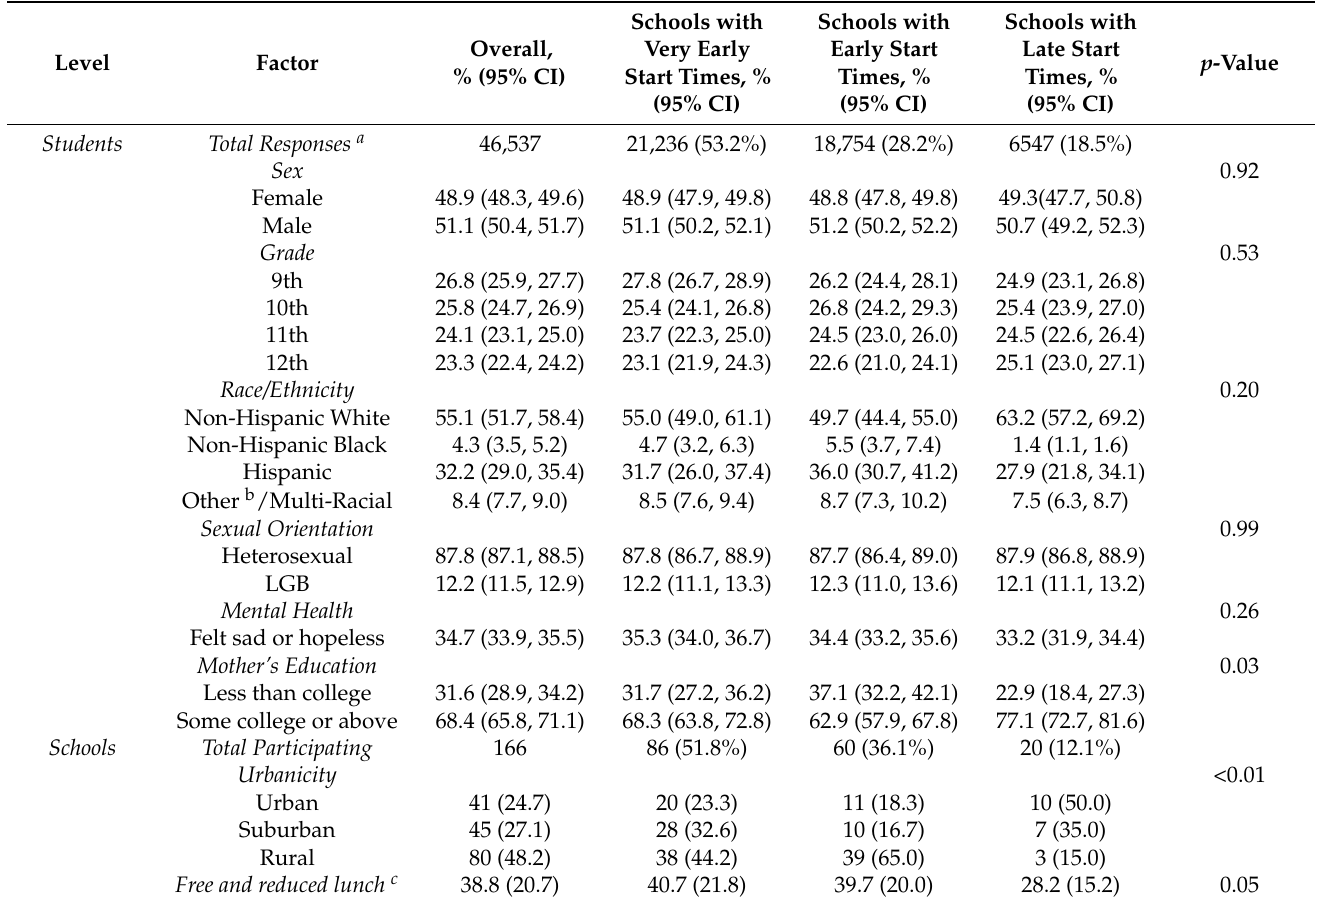
Table 1. Individual and school-level demographic